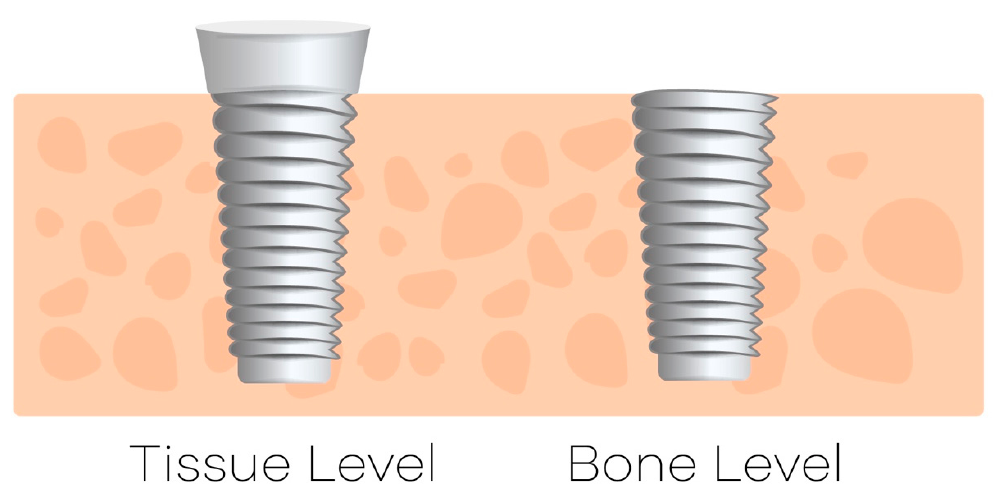
Figure 3. Location of the implant–abutment junction in relation to bone crest for tissue- and bone-level implants.